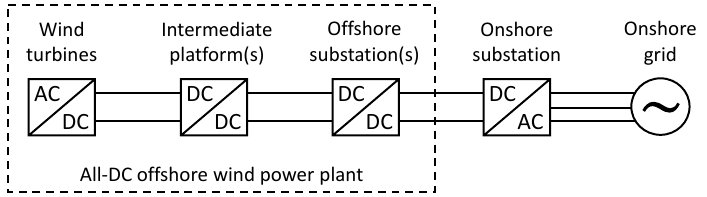
Figure 5. Schematic representation of an all-DC offshore wind power